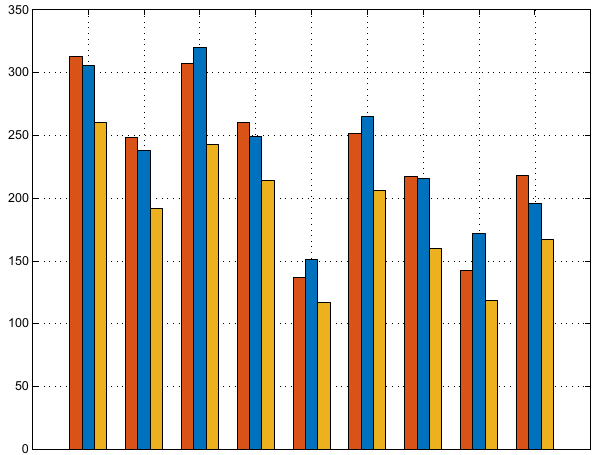
Figure 12. Number of short-life anticyclonic eddies formed (red bars) and terminated (blue bars) in each sector. The yellow bars indicate the structures formed and terminated in the same sector.